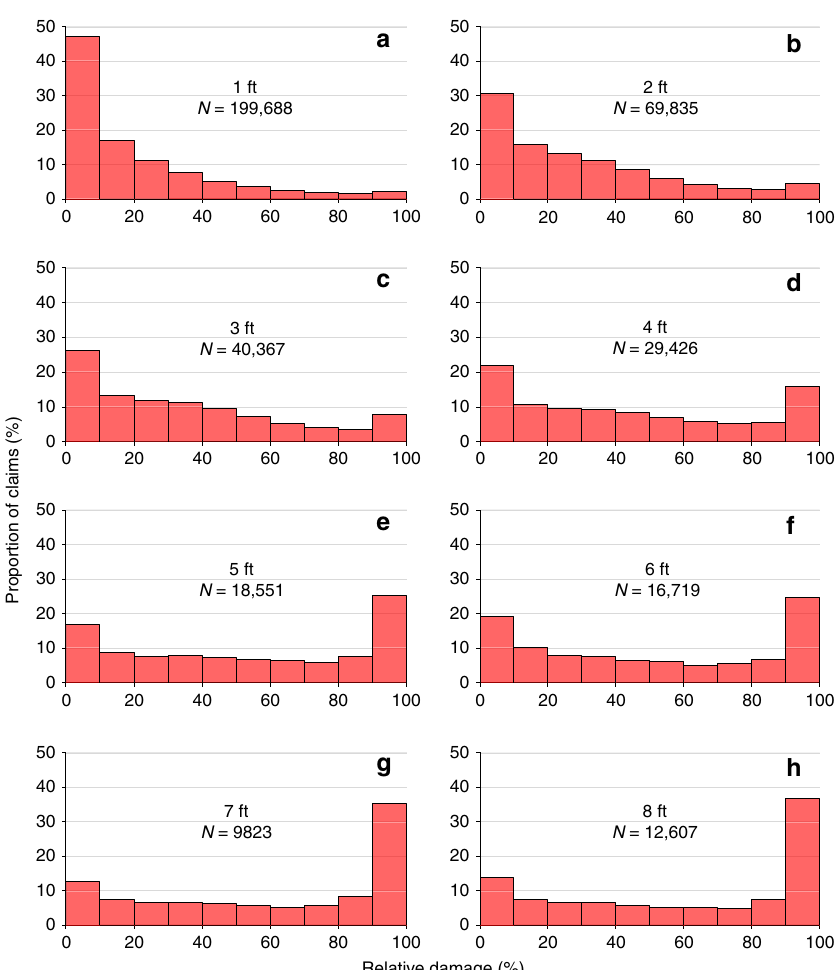
Fig. 2 The shape of NFIP-derived depth – damage distributions. Each panel shows the proportion of observations which fall within a relative fl ood damage bin (structural damages as a percentage of building value, binned in increments of 10% between 0 and 100%) for each inundation depth increment from 1 to 8 feet a – h from the NFIP claims database. Totals here are for single-family residential buildings with one story and no